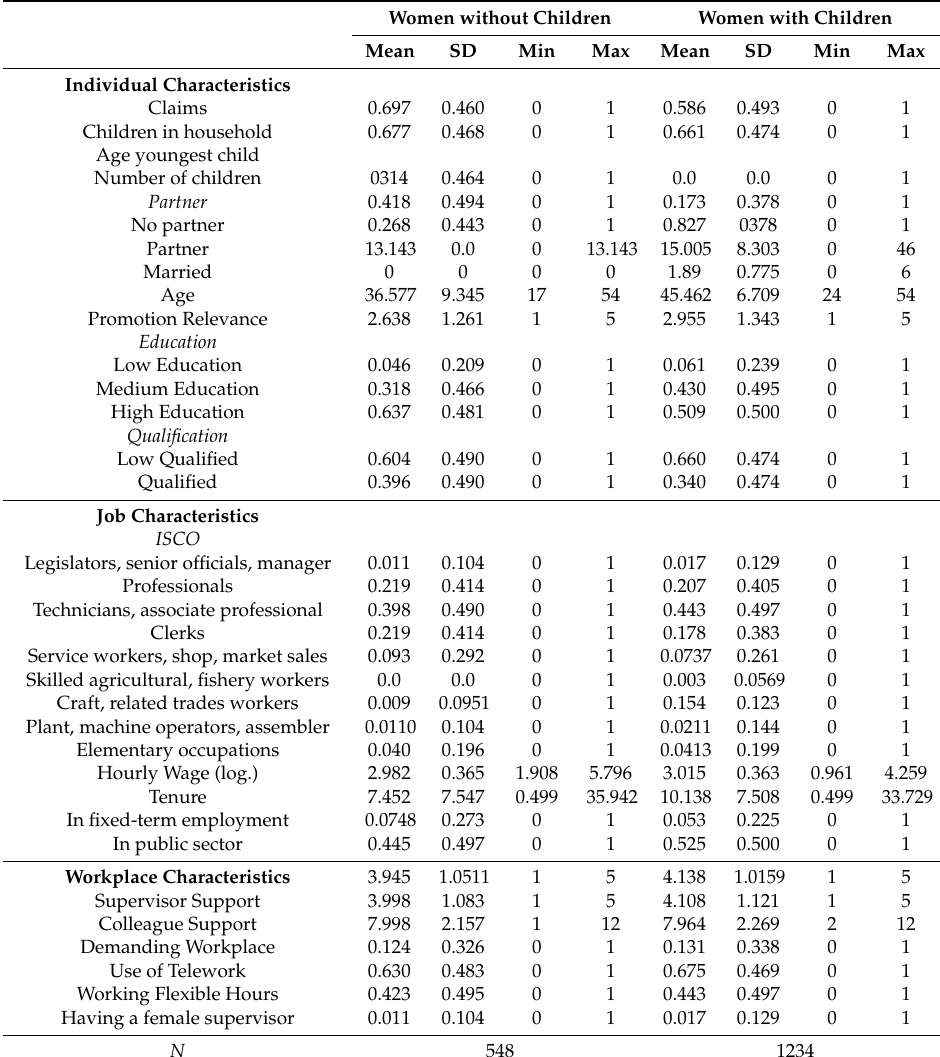
Table 2. Means and standard deviations of study variables for women ( N =